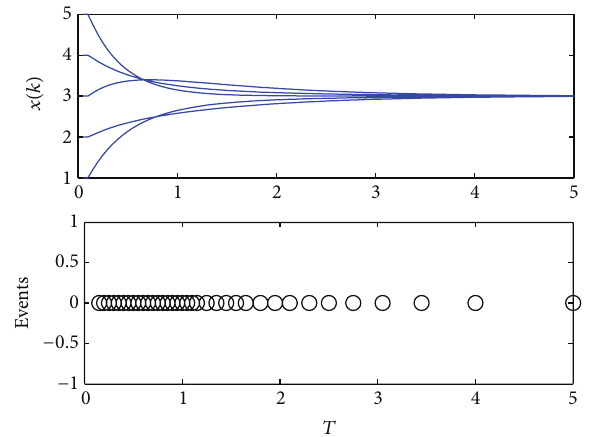
Figure 6: Protocol (26) for 𝑝 = 0.5 and 𝜏 = 0.025 s.